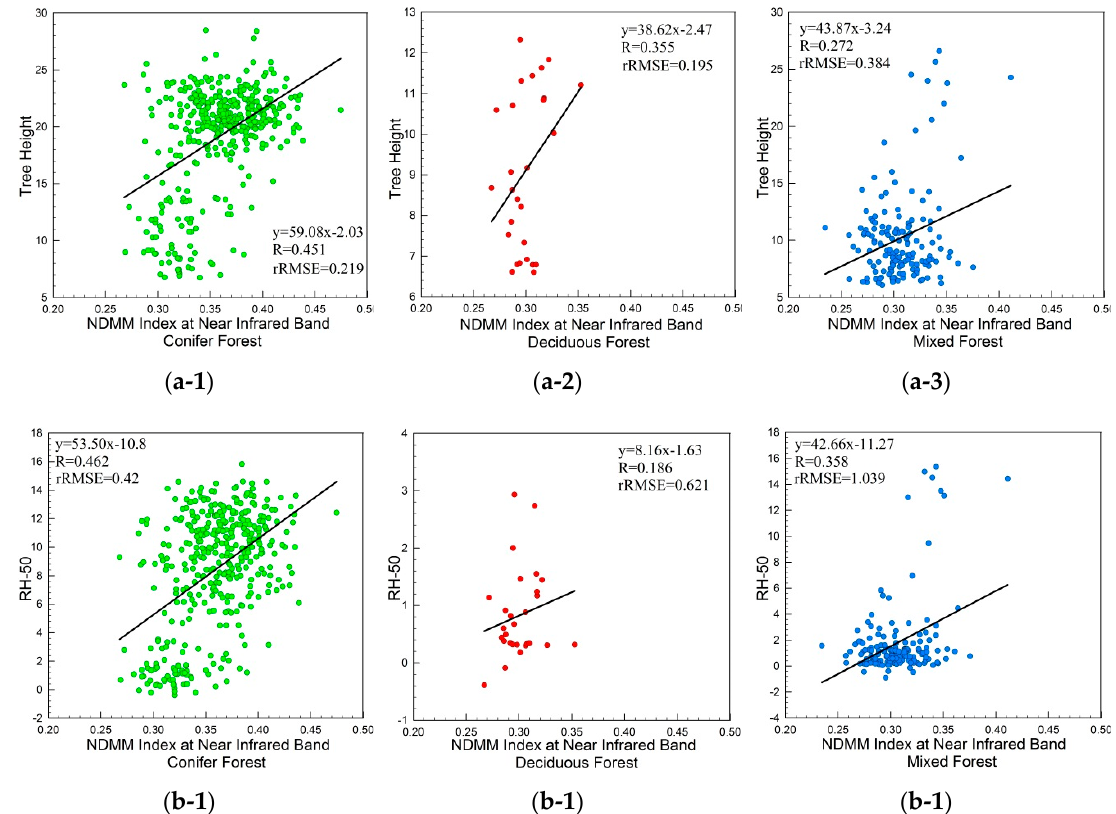
Figure 6. Relationship between the tree height (RH100 and RH50) and bidirectional reflectance distribution factor (BRDF) Index at the near-infrared band for three kinds of forests in Howland. ( a-1 ), ( a-2 ), and ( a-3 ) represent the relationship between the tree height and NDMM Index at near-infrared band for the conifer, deciduous, and mixed forests, respectively; ( b-1 ), ( b-2 ), and ( b-3 ) represent the relationship between RH-50 and NDMM Index at near-infrared band for the conifer, deciduous, and mixed forest, respectively.